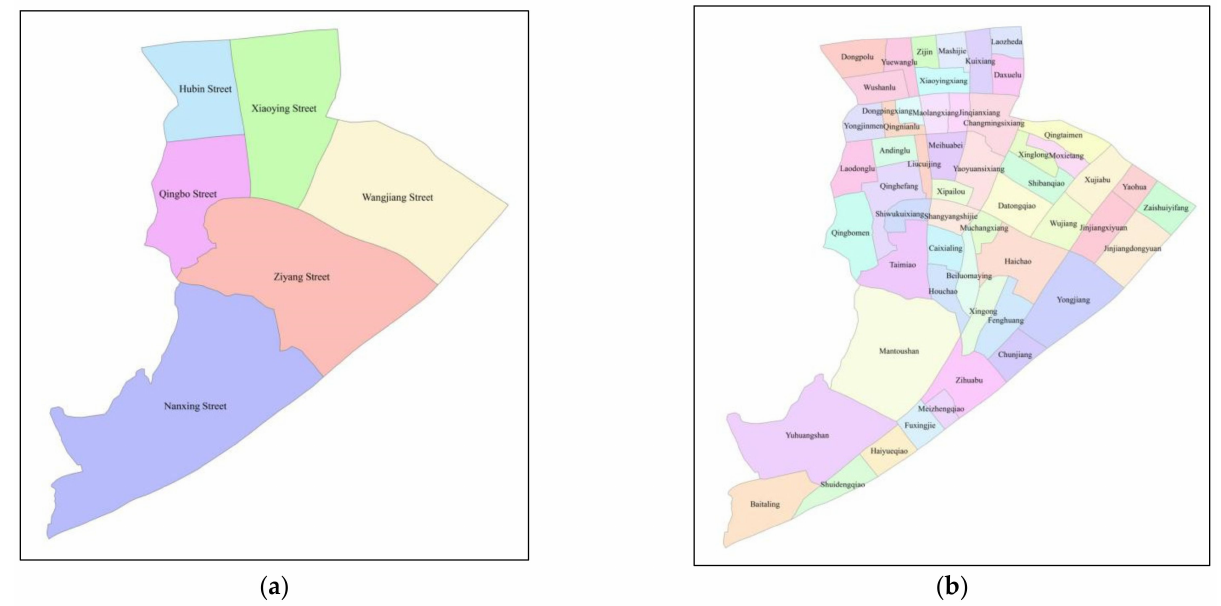
Figure 2. Streets and communities of Virtual Shangcheng City: ( a ) streets; ( b )